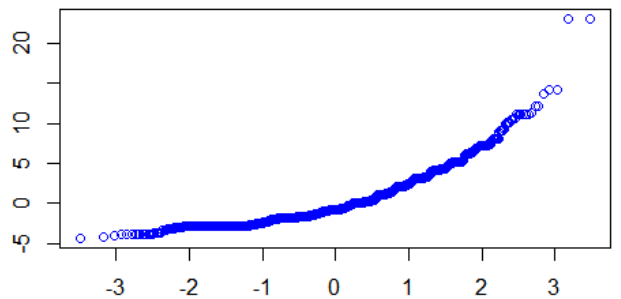
Figure 11. Q–Q plot of patent keyword data for BART modeling.